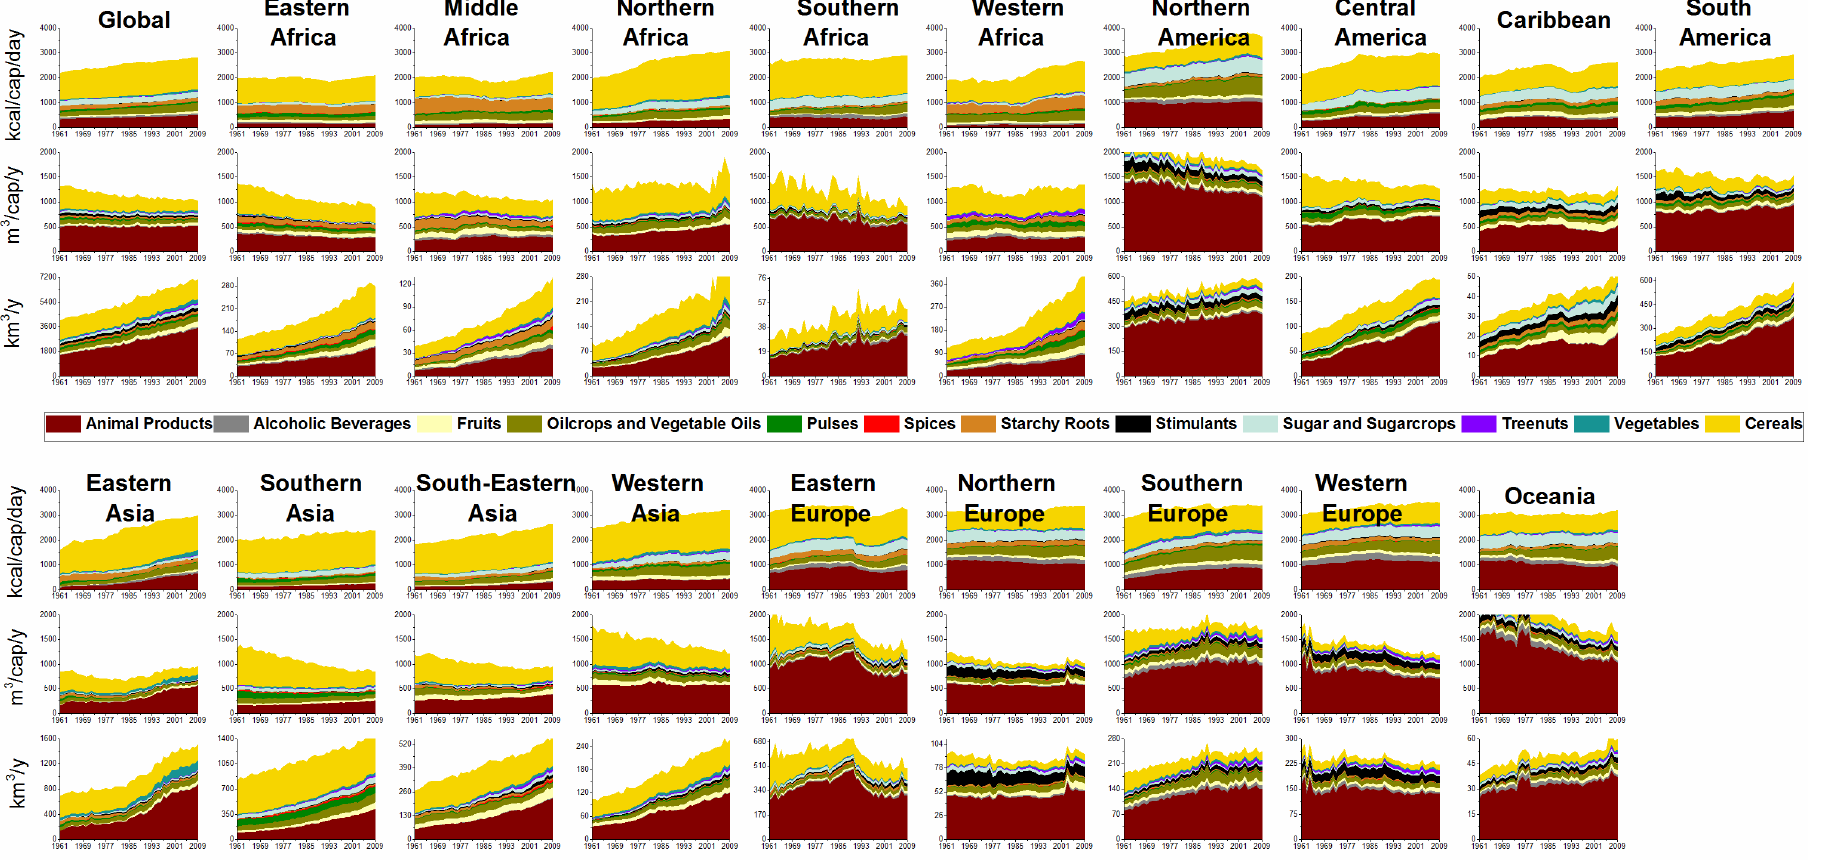
for food. Changes in food supply ( top , kcal/capita/day), per capita WF cons for food ( lower , km 3 /y) at subcontinental levels from 1961 to 2009; the values are shown in 12 cons